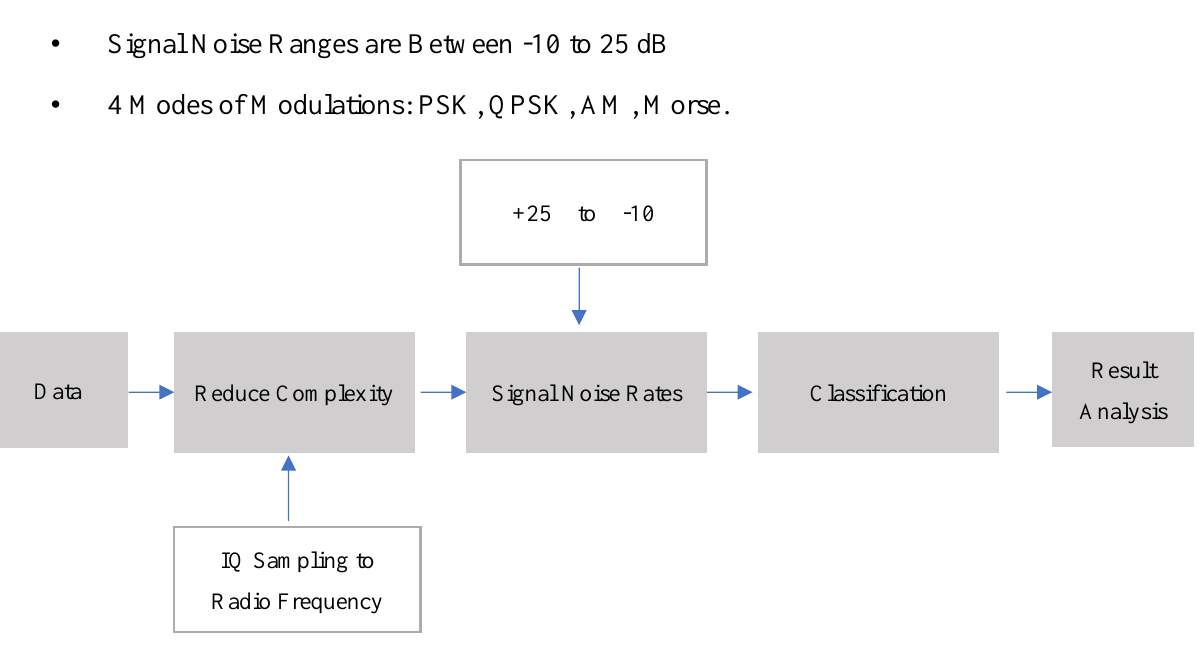
Figure 1. The Flow Diagram of The Proposed